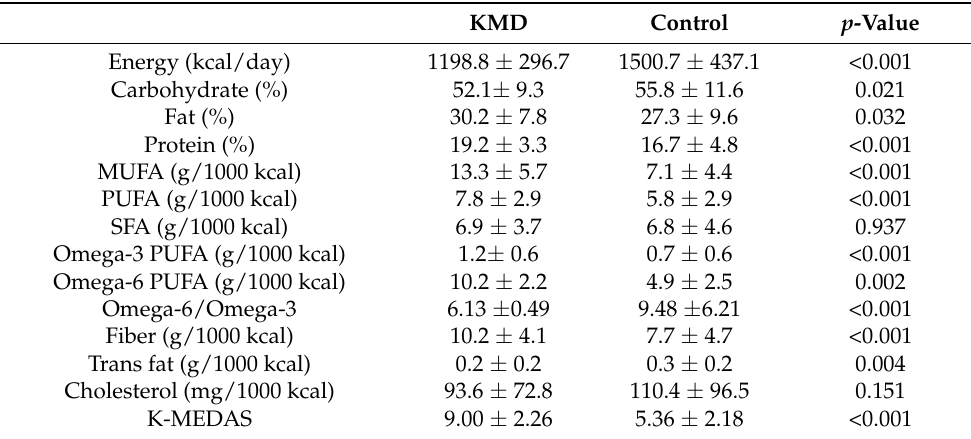
Table 2. Diet composition of KMD and control